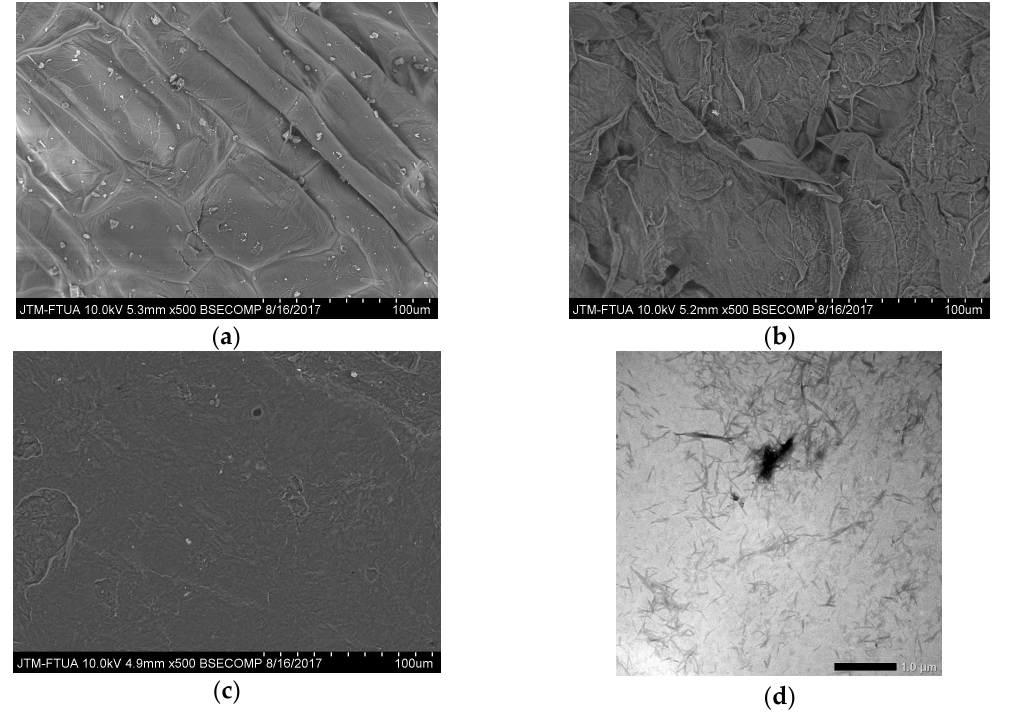
Figure 1. SEM images of morphological: ( a ) raw water hyacinth; ( b ) bleached fiber; ( c ) acid hydrolysis fiber; ( d ) TEM images of nanofiber cellulose (NFC) water hyacinth after sonication for 1 h.